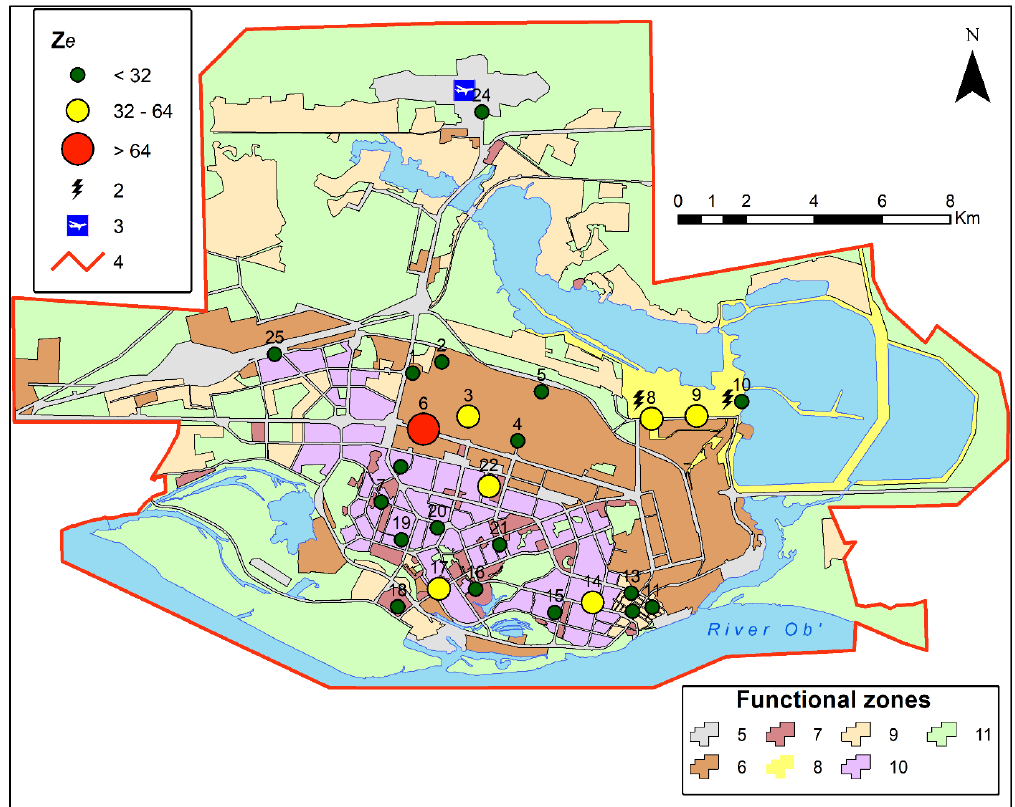
Figure 2. Spatial distribution of Ze values: 1—sampling sites; 2—power plants; 3—airport; 4—city border; 5—industrial and warehouse area; 6—high-rise residential area; 7—low-rise residential area; 8—power plant area; 9—public and business area; 10—modern business zones; 11—recreational area, urban forests, green spaces.